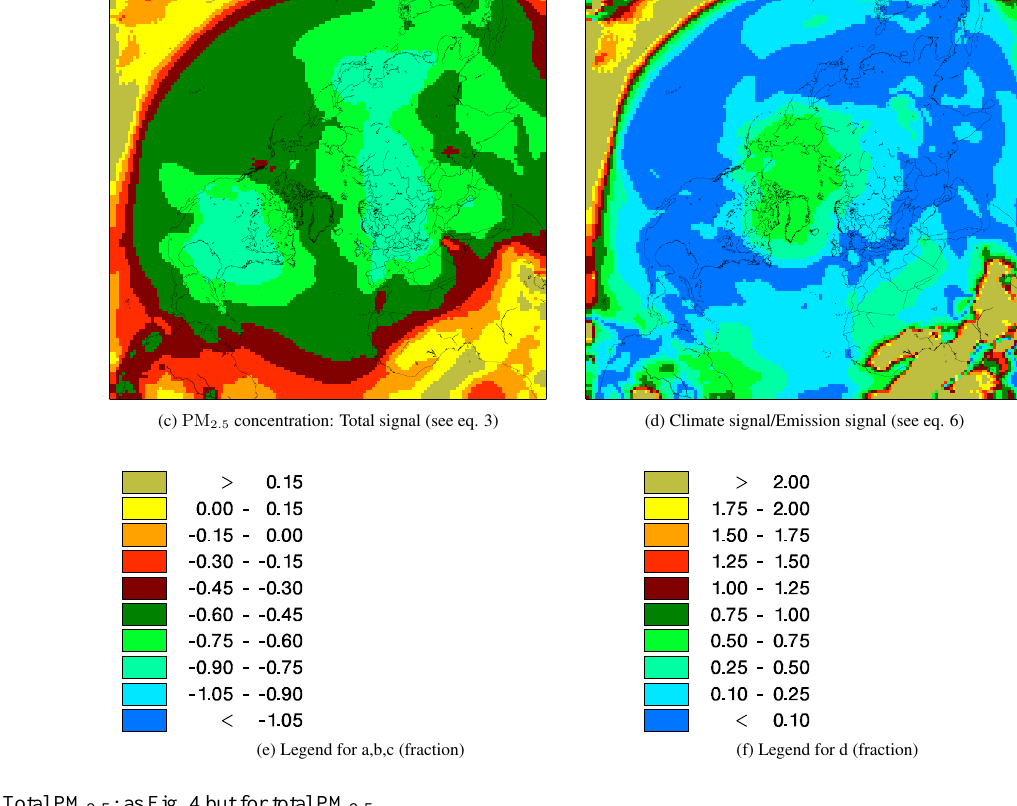
Fig. 7: Total PM 2 : 5 : As Fig. 4 but for total PM 2 : 5 Fig. 7. Total PM 2 . 5 : as Fig. 4 but for total PM 2 . 5 .